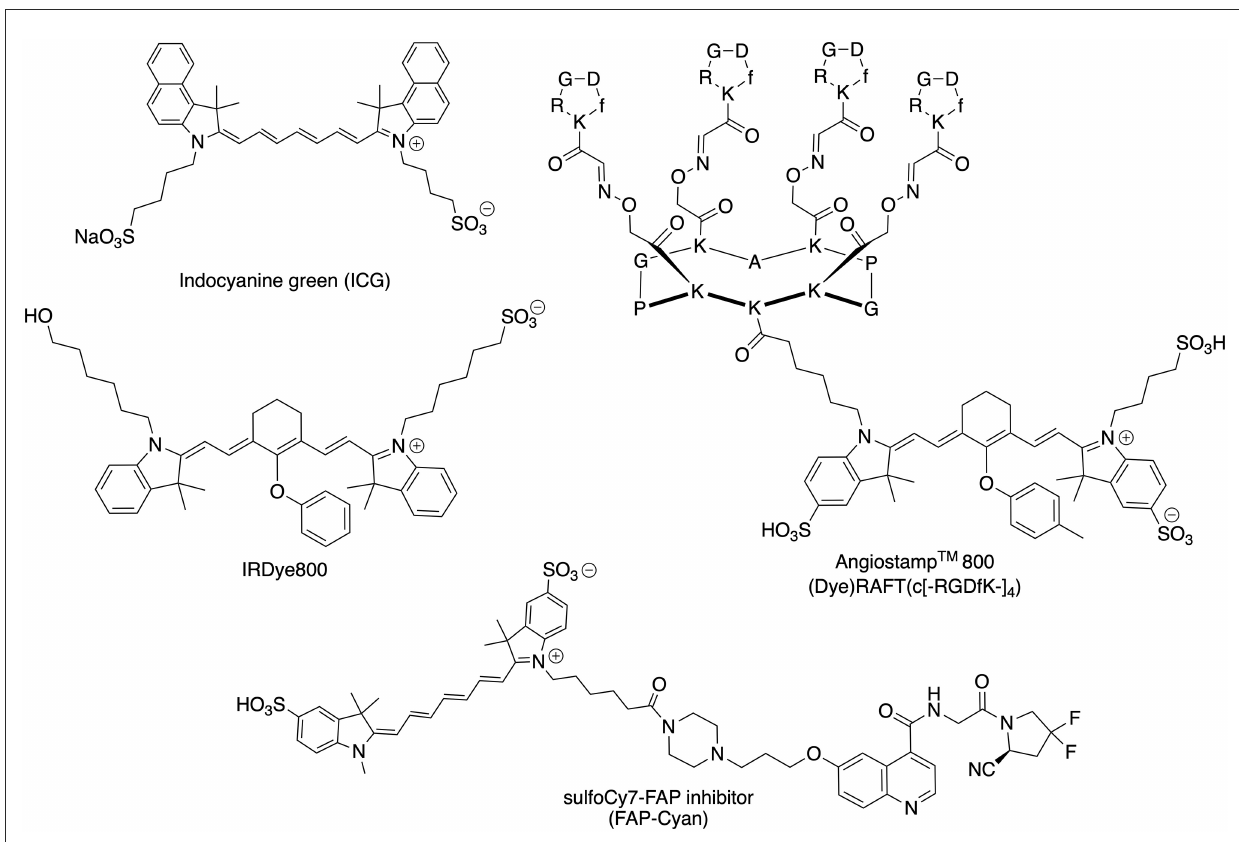
FIGURE1 Chemical structures of the NIR dyes (ICG, IRDye600, Angiostamp TM , and FAP-Cyan) used in this work.